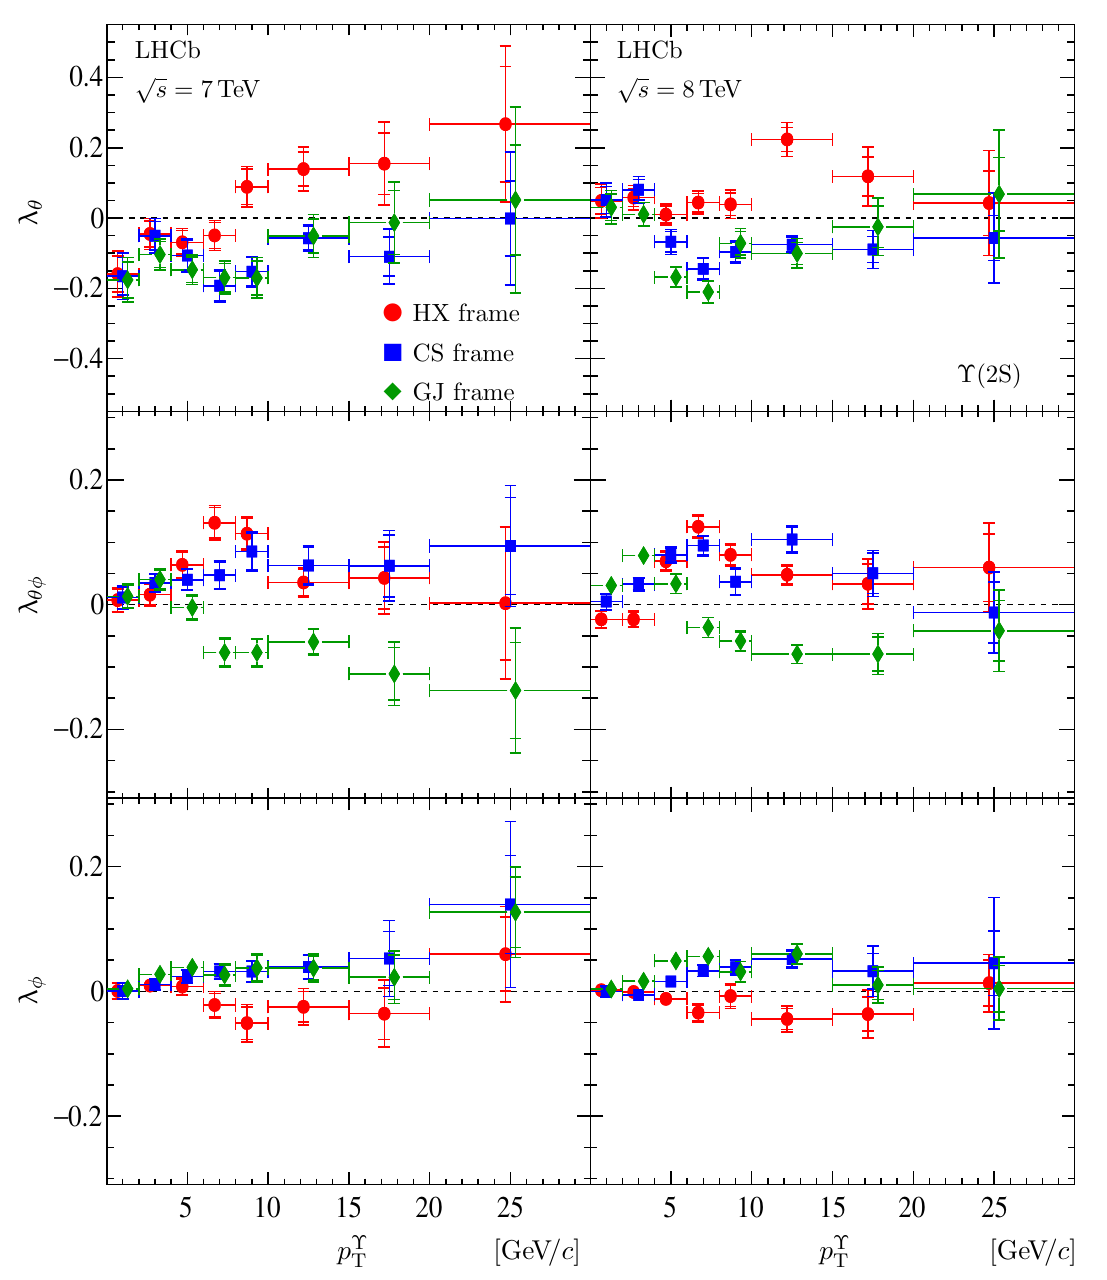
Figure 13 . The polarization parameters (top) (cid:21) (cid:18) , (middle) (cid:21) (cid:18)(cid:30) and (bottom) (cid:21) (cid:30) , for (cid:7)(2S) mesons as a function of p (cid:7) , for the rapidity range 2 : 2 < y (cid:7) < 4 : 5, for data collected at (left) T p and (right) s = 8 TeV. The results for the HX, CS and GJ frames are shown with red circles, blue squares and green diamonds, respectively. The inner error bars indicate the statistical uncertainty, whilst the outer error bars indicate the sum of the statistical and systematic uncertainties added in quadrature. Some data points are displaced from the bin centers to improve visibility.